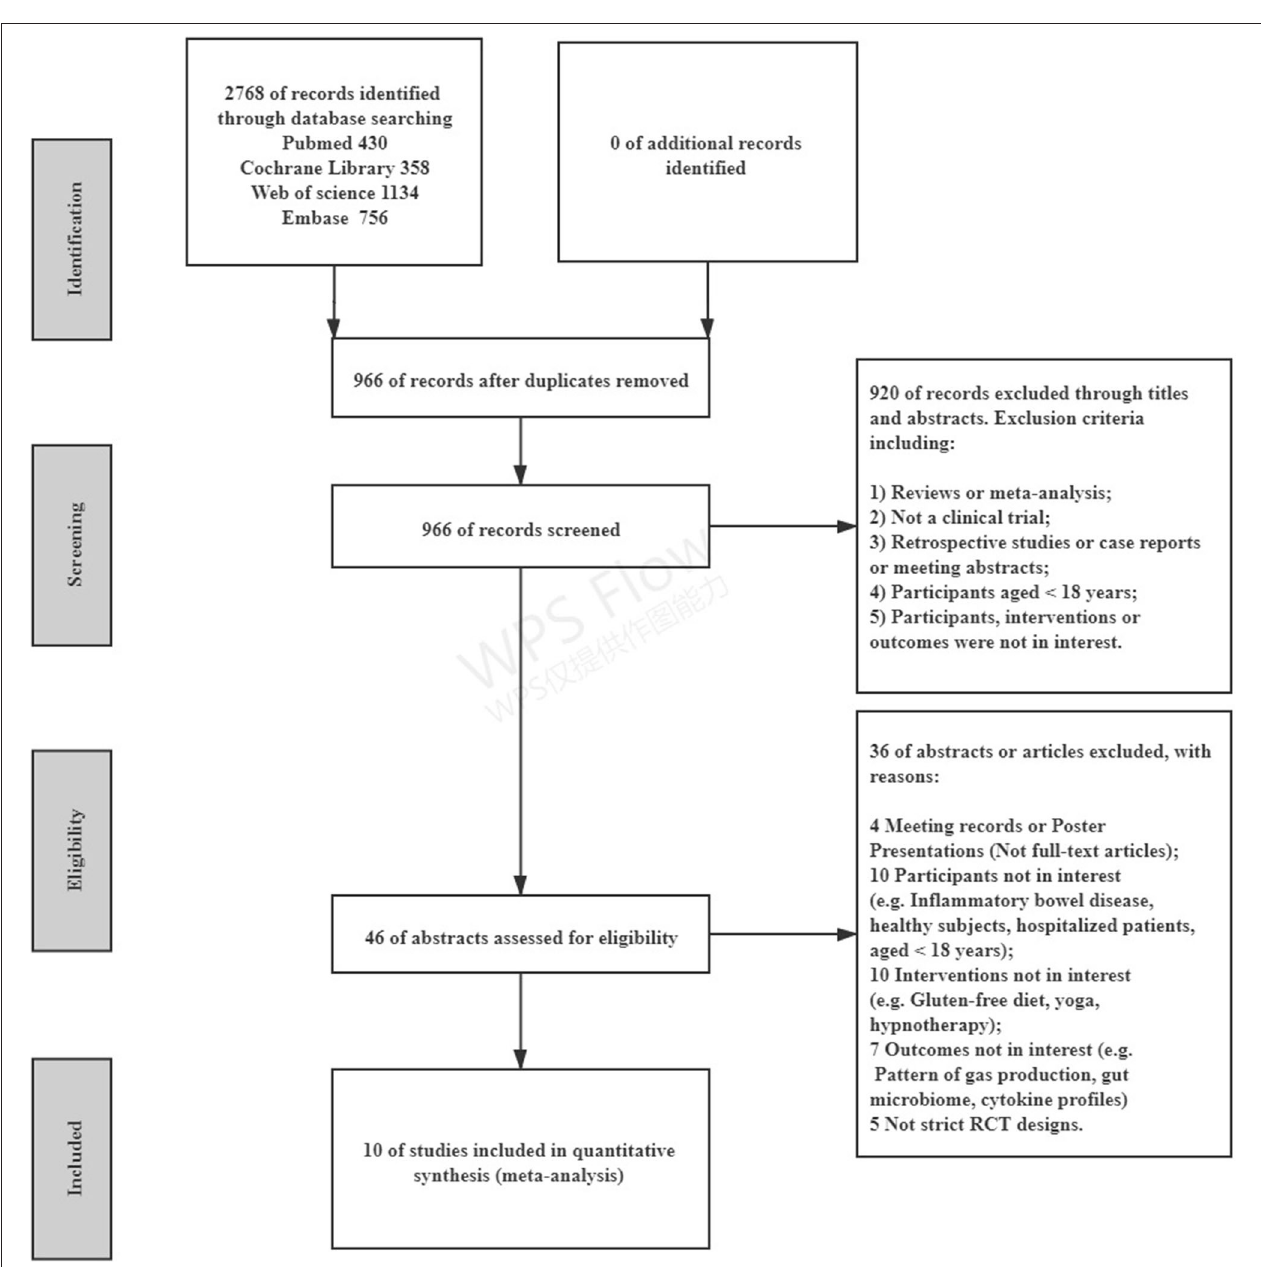
FIGURE 1 | Preferred reporting items for systematic reviews and meta-analyses (PRISMA) flow diagram of the included studies. RCT, randomized controlled trial.